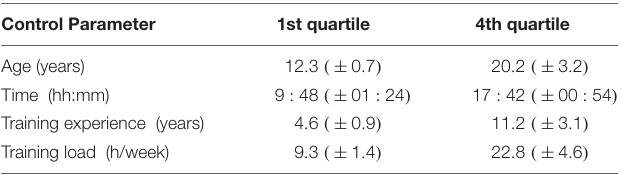
TABLE 2 | Group characteristics for group comparisons based on first and fourth quartile. Control